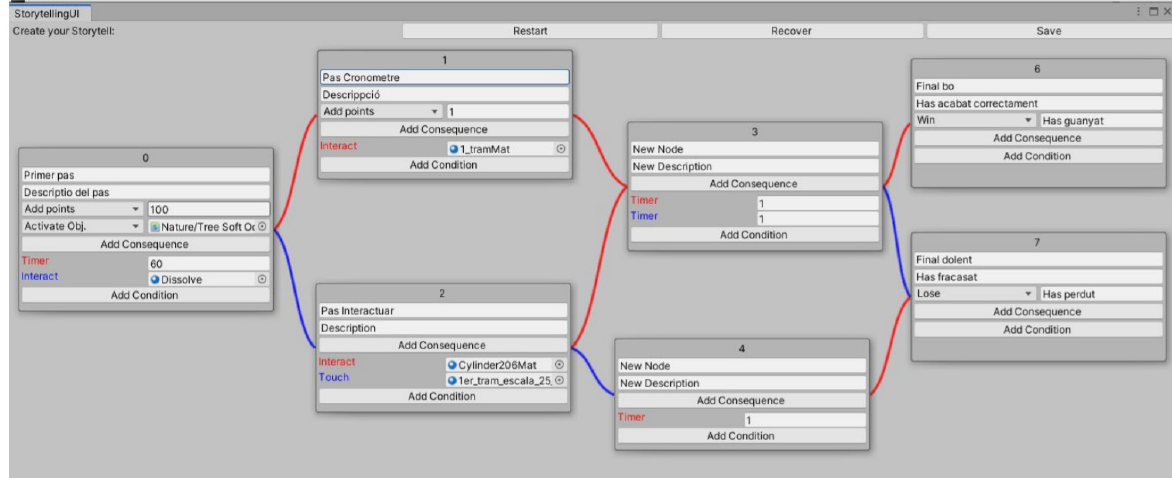
Figure 20. Conceptual diagram of the generic structure for the programming of the storytelling, based on Unity3D ® .